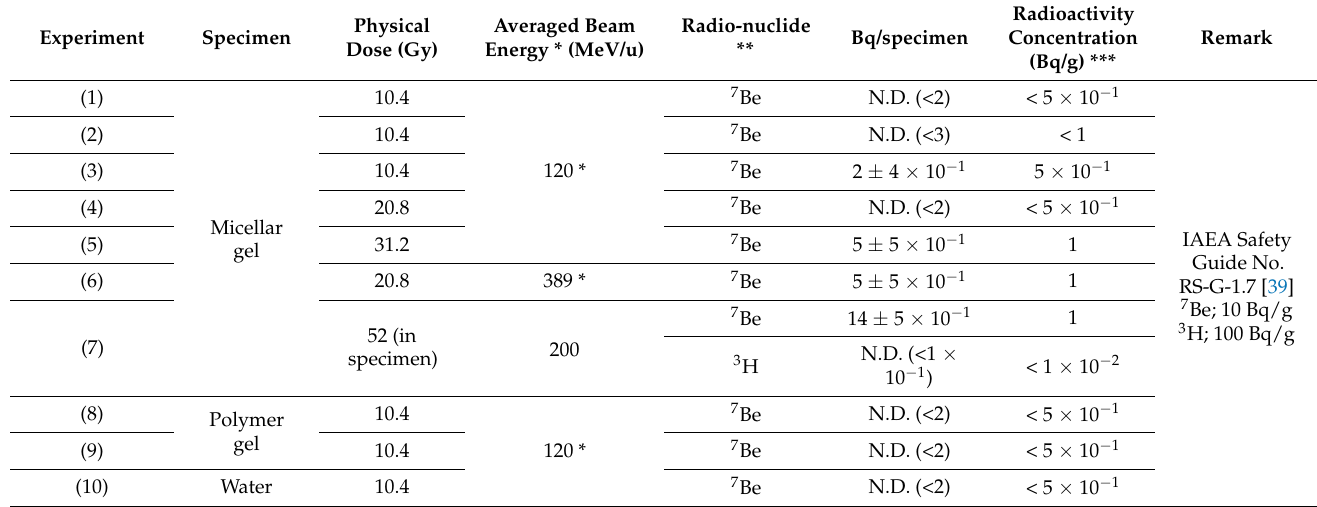
Table 5. Measured radioactivity in all the experiments after irradiation by carbon ion beams.